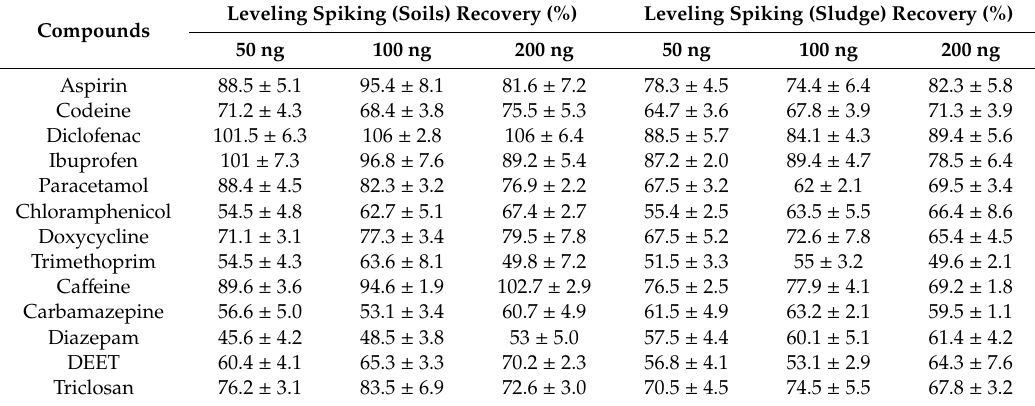
Table 2. Mean recoveries (%) and standard deviation ( n = 6) of the target compounds in the spiked soil and sludge samples.